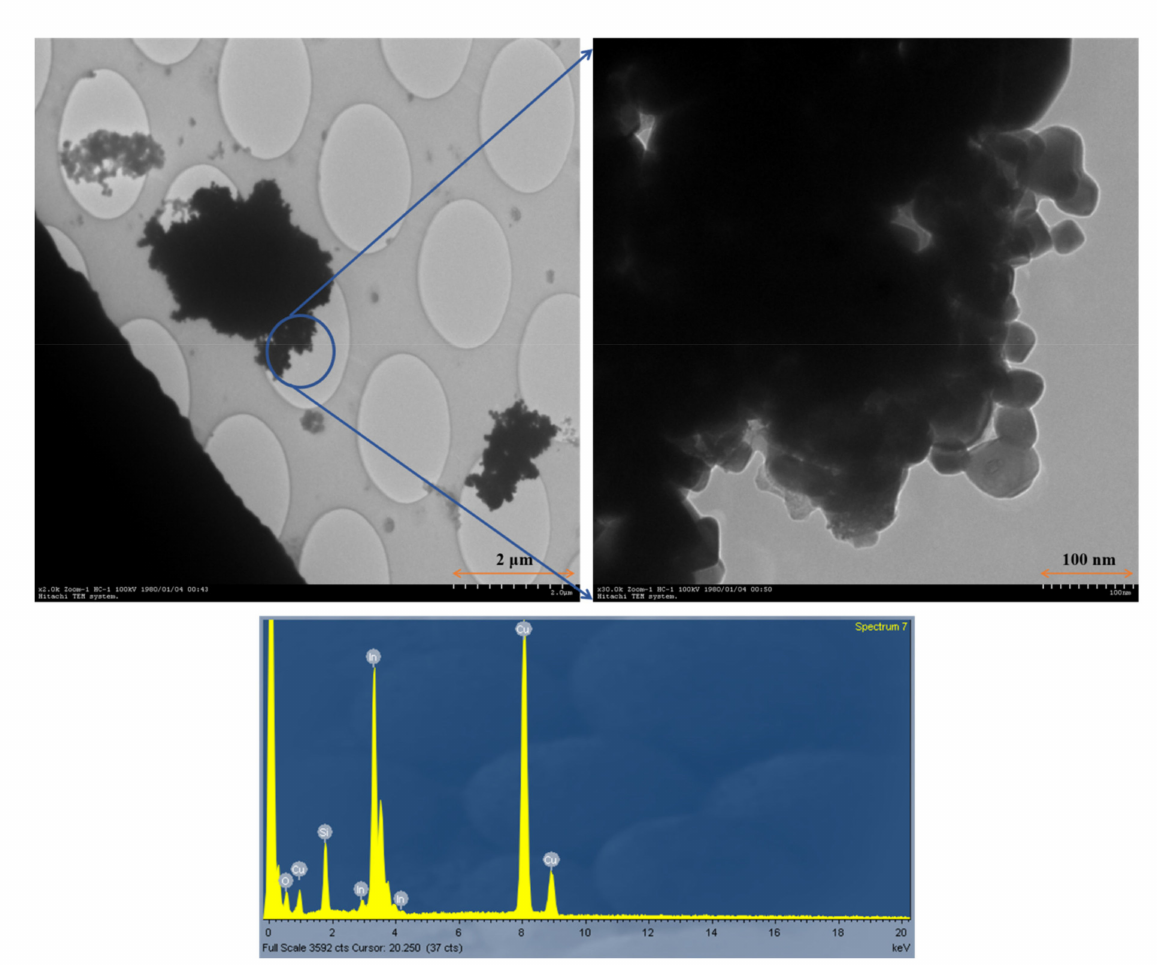
Figure 4. Transmission electron micrograph (TEM) of indium-containing particles and energy dispersive spectroscopy (EDS) analysis. Cu is derived from the Cu-200 mesh grid used to support the presence of particles, and silicon and oxide may be derived from the atmosphere